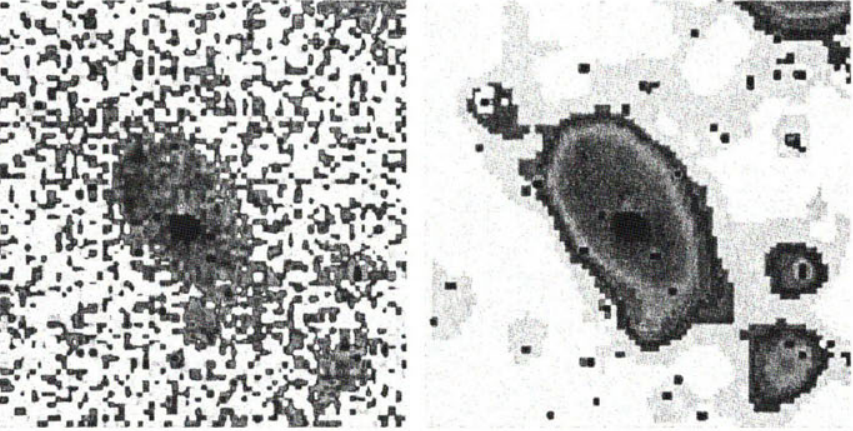
Fig. 3. A combined image of 094-2210 (left panel) and the image after adaptive filtering (right panel). Intensity cutoffs of the images in WFPC2 intensity counts are 0 (lower) and 25